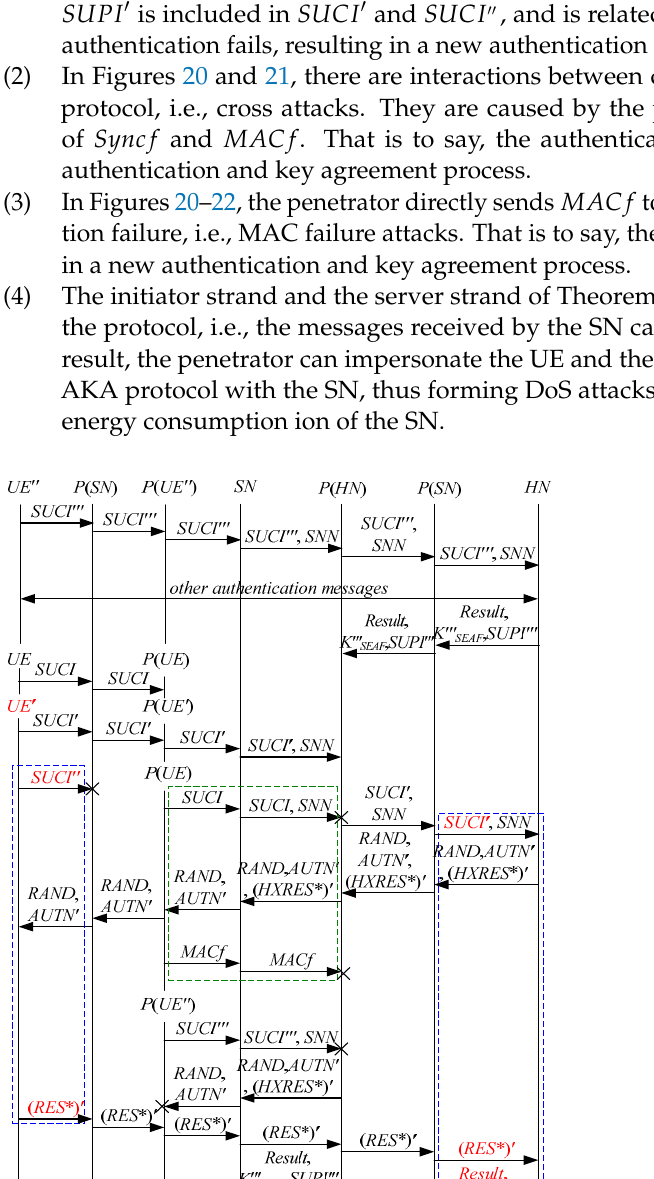
Figure 21. The twentieth attack scenario of the 5G AKA protocol.